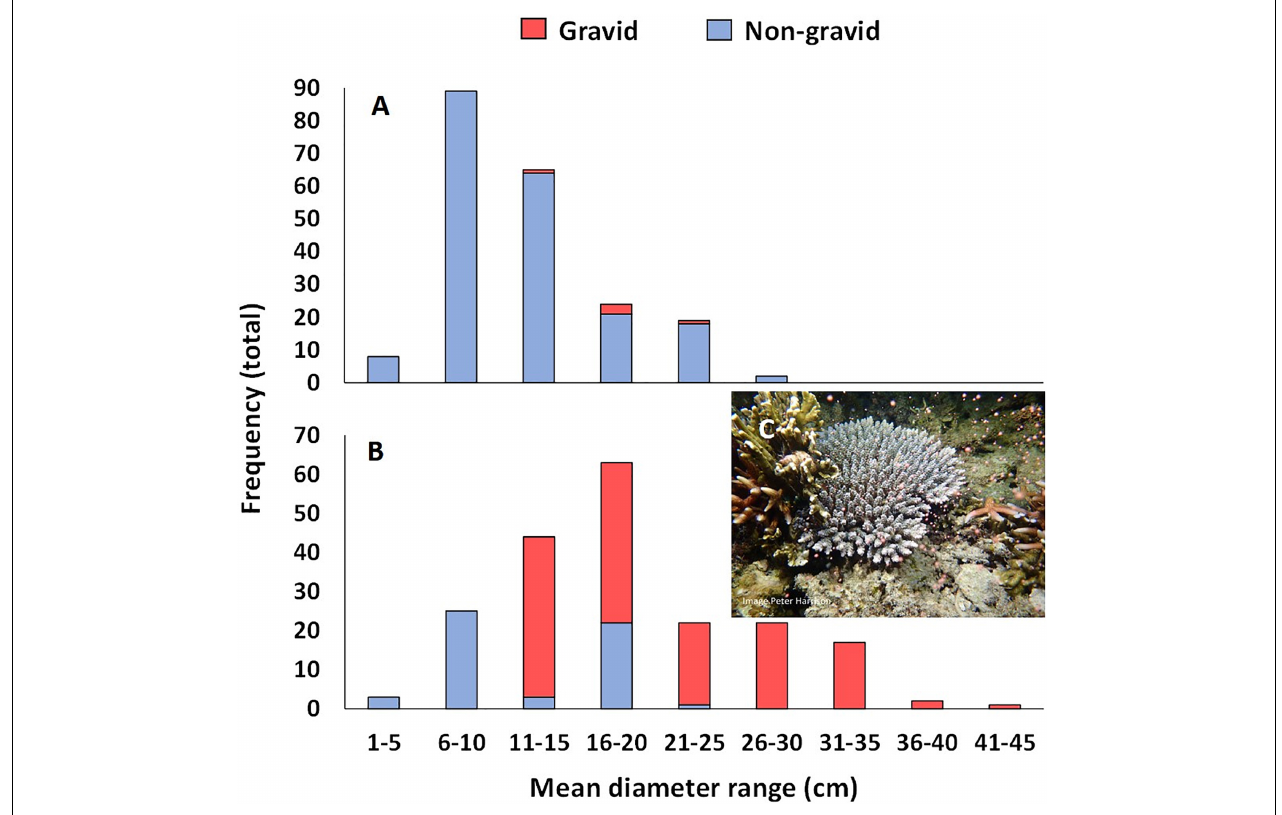
FIGURE 8 | Size frequency plots of mean colony size of gravid and non-reproductive A. tenuis colonies in the three larval enhanced plots (A) in June 2018 and (B) March 2019, and (C) a three year old colony spawning in a larval restoration plot on 25 April